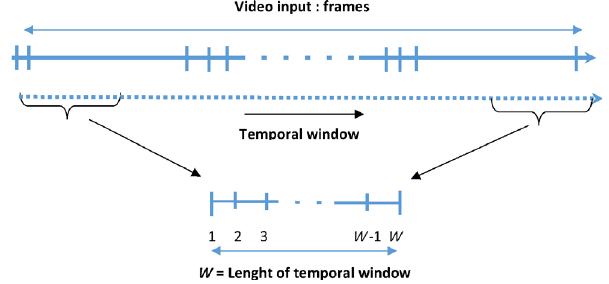
Fig. 10 Fall detection in video.